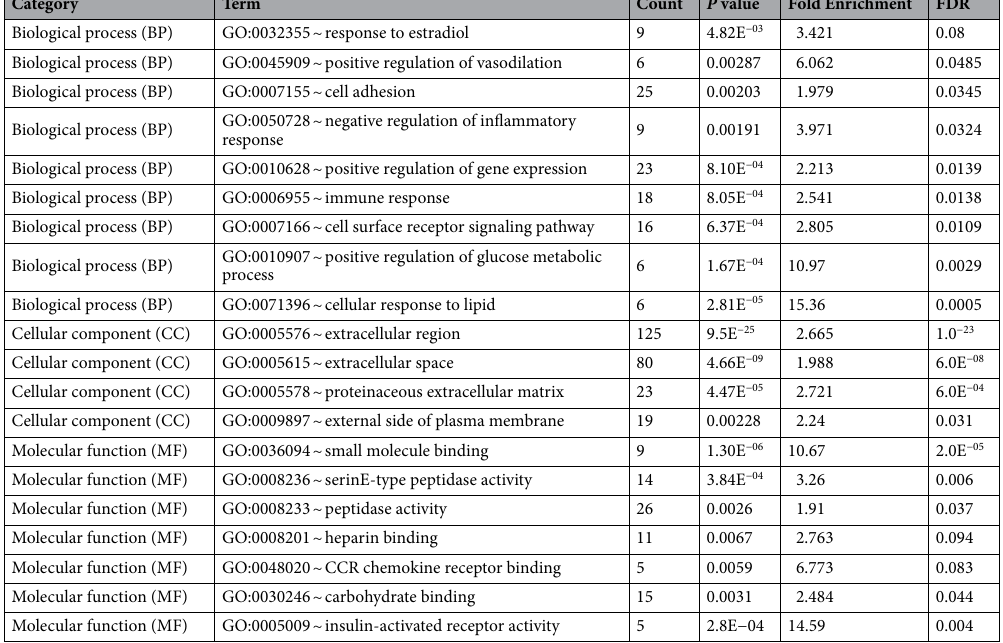
Table 1. Whole Gene ontology (GO) and pathway analysis of differentially expressed genes between CXCL12- day8 and control using DAVID tool. The cutoff for significance was set by P < 0.05, FE < 1.5. biological process (BP), cellular component (CC), and molecular function